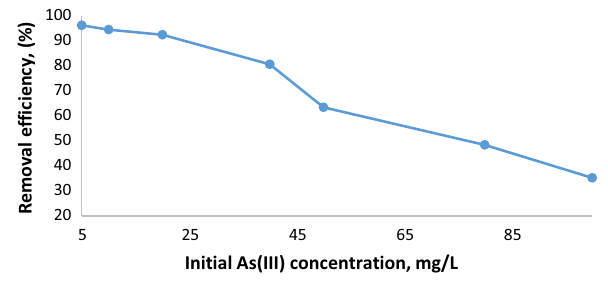
Fig. 7 Effect of initial As(III) concentration on the removal of As(III)